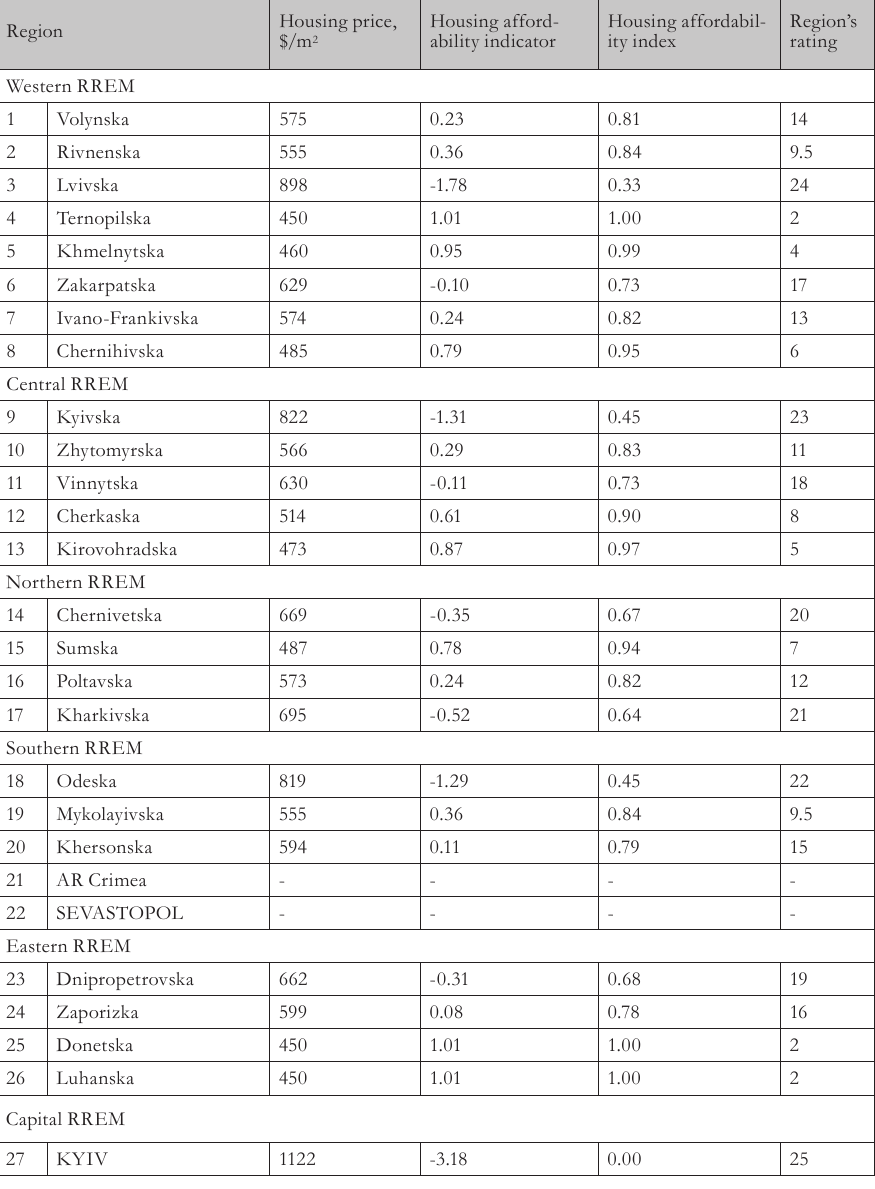
Tab. 4 – Housing affordability in Ukraine regions according to their division into RREM, on January 1, 2017, (excluding the temporarily occupied territory of the Autonomous Rep. of Crimea, the city of Sevastopol and parts of the zone of anti-terrorist operation in Donetska, Luhanska regions). Source: Ministry of Justice of Ukraine. (2019), State Statistics Service of Ukraine